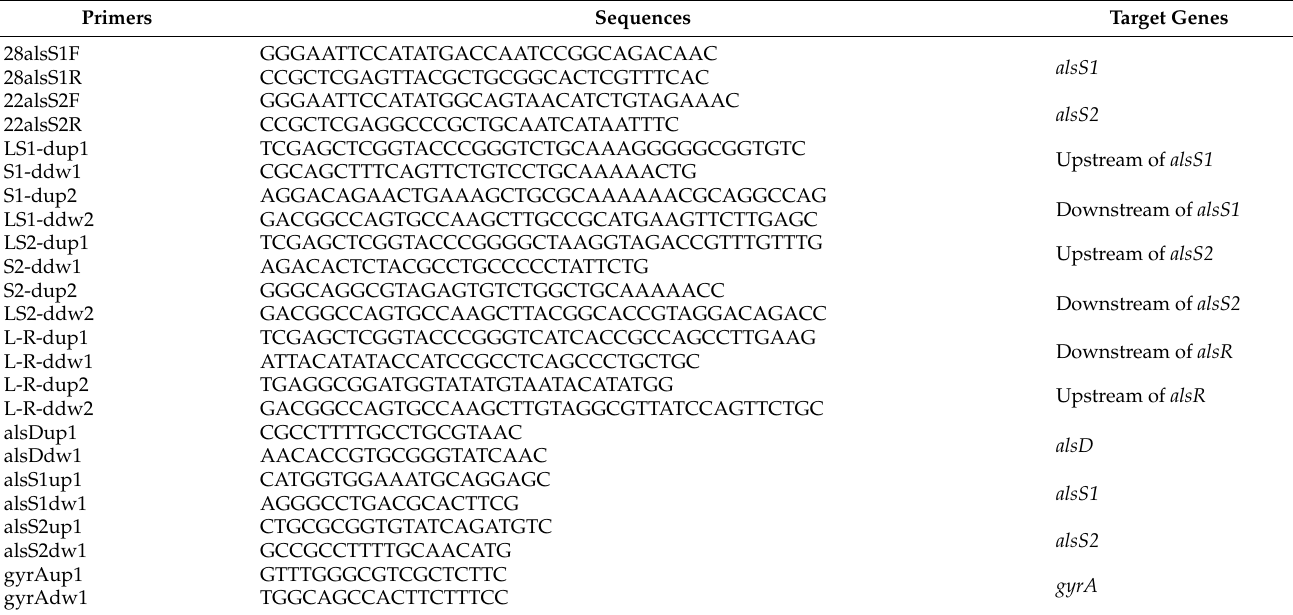
Table 2. The primers used in this